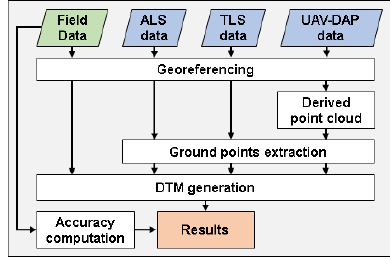
Figure 3. Overview of the methodological approach